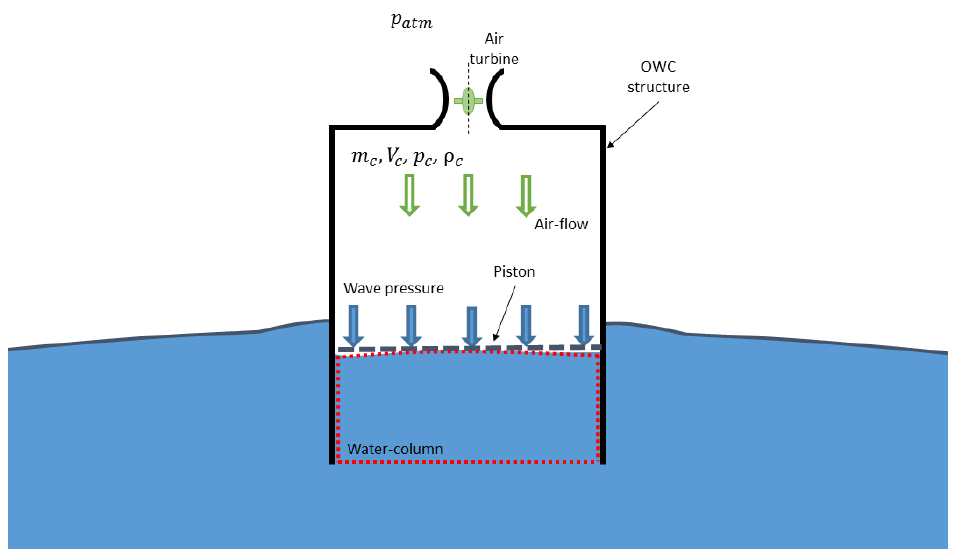
Figure 3. Schematic representation of oscillating water columns (OWC) devices, including the water column, turbine and the horizontal piston that represents the air-water interface in the piston-model